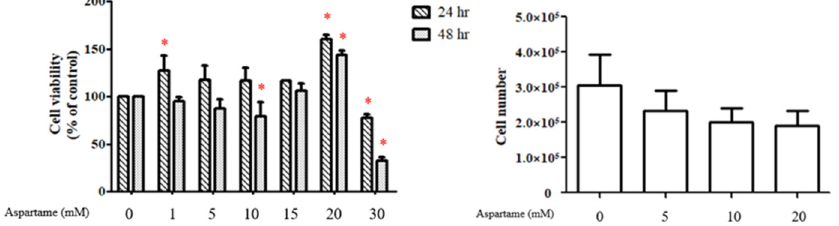
Figure A1. Pilot KGN cell experiment of different doses of aspartame treatment on cell viability and numbers. * p < 0.05 as compared with control.